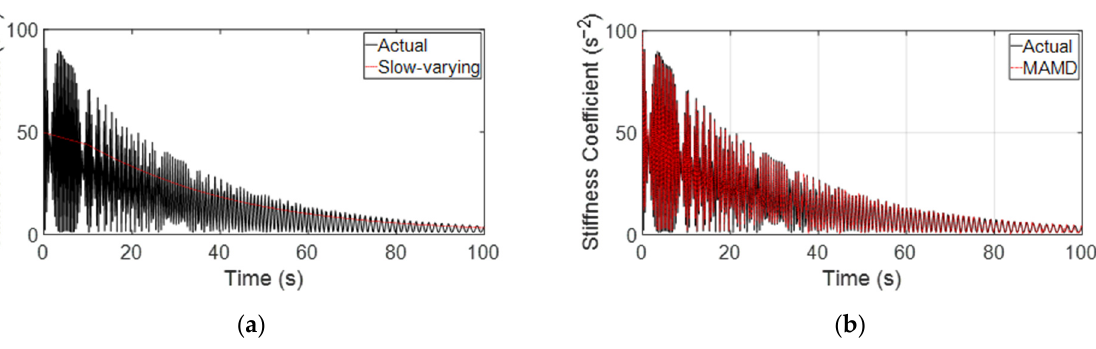
Figure 9. System stiffness coefficient by optimized MAMD: ( a ) slow-varying component; ( b ) identified coefficient.